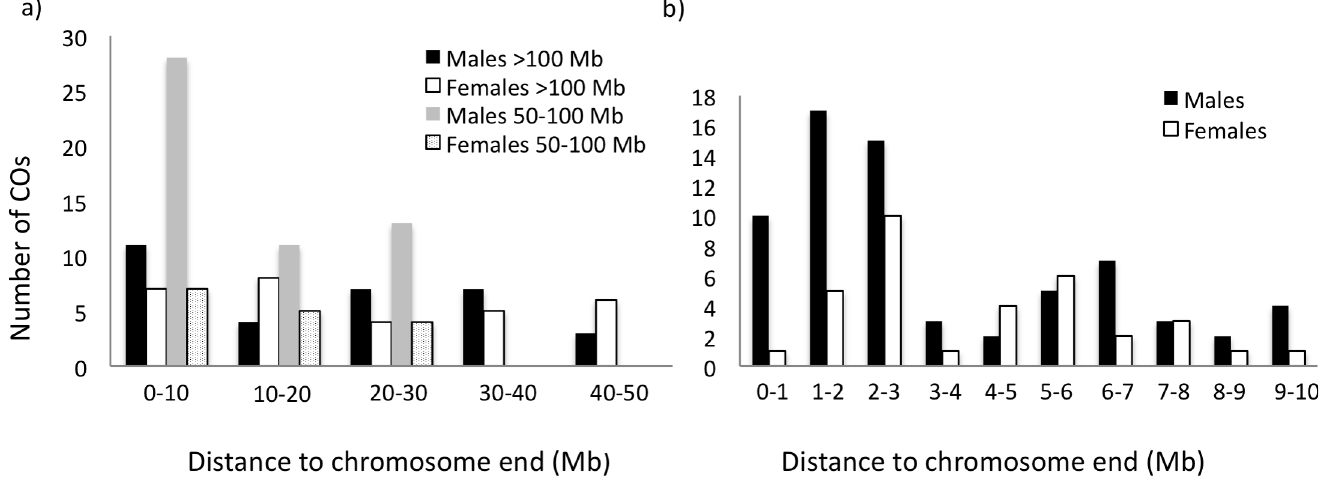
Fig 3. Distribution of the number of crossover events in relation to distance to nearest chromosome end. ( a ) chromosomes > 100 Mb (males, black; female, white) and chromosomes 50 – 100 Mb (males, grey; females dotted) for 10 Mb intervals, and ( b ) the terminal 10 Mb of all chromosomes in 1 Mb intervals (males, black; female, white).